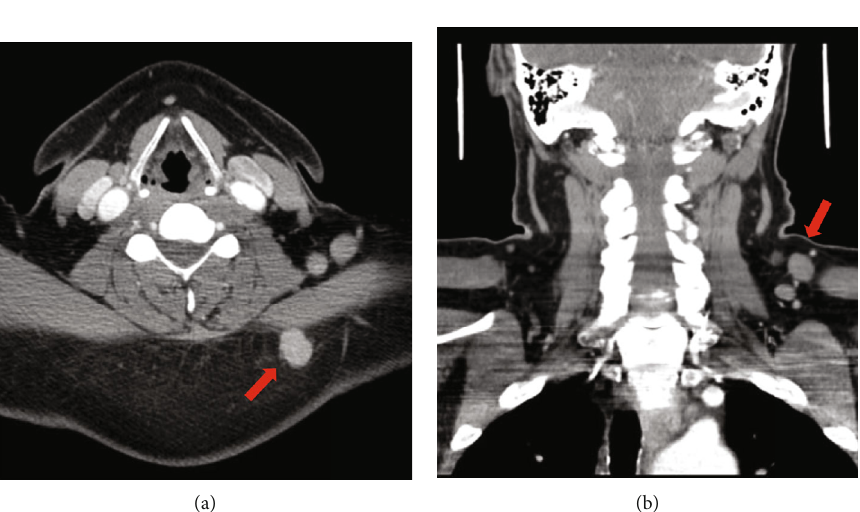
Figure 1: (a, axial view) CT scan with contrast demonstrated a hyperdense rounded mass in the subcutaneous tissue of the left side of the neck, posterior to the trapezius muscle, corresponding to the patient ’ s palpable primary mass (red arrow). (b, coronal view) Several lymph nodes (red arrow) in the posterior triangle anterior to the trapezius muscle ranging in size up to 1.5cm in diameter were demonstrated on CT